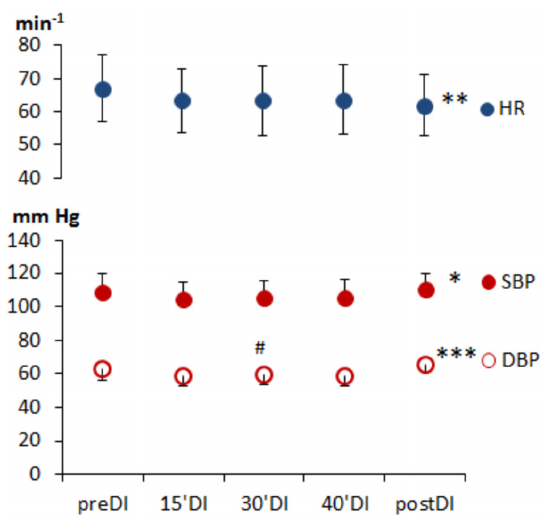
Figure 1. Heart rate and blood pressure in subjects during the “dry” immersion session. HR, heart rate; SBP, systolic blood pressure; DBP, diastolic blood pressure. The significance of the Friedman test: * p < 0.05, ** p < 0.01, and *** p < 0.001; the difference from the preDI value # p < 0.05. HRV parameters were highly reproducible among individuals during the DI